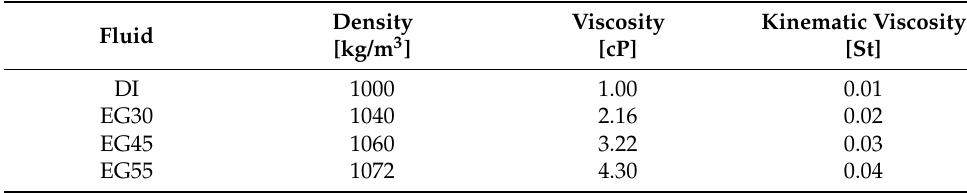
Table 1. Properties of fluids used in the presented